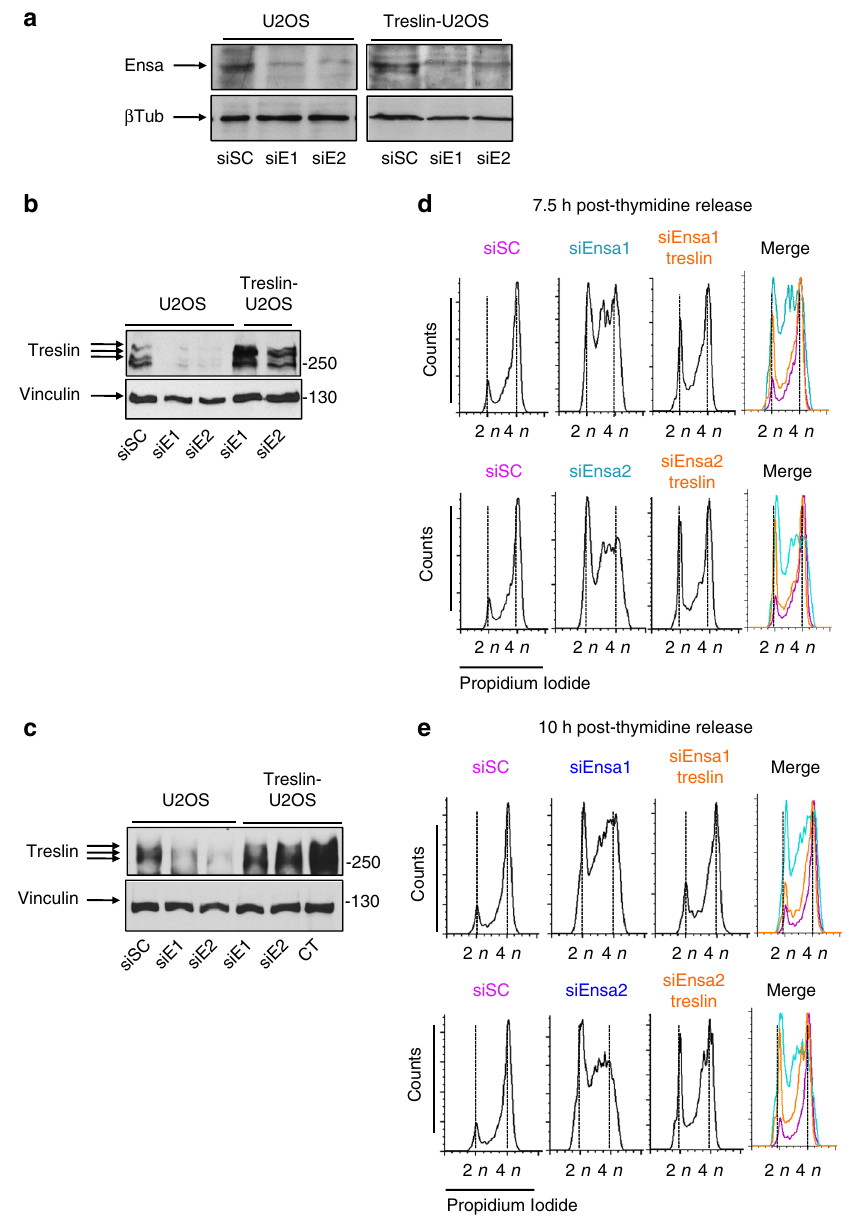
Fig. 8 Overexpression of Treslin in Ensa siRNA-treated cells rescues normal S phase. a Parental or U2OS cells stably overexpressing AcGFP-Flag-Treslin were transfected with scramble (siSC) or Ensa siRNAs #1 (siE1) or #2 (siE2) (for parental) or with Ensa siRNA #1 and #2 (for AcGFP-Flag-Treslin overexpressing cells) and the levels of Ensa and β -tubulin as a loading control, checked by western blot. Cells were synchronised in G1 – S by thymidine block 24 h later and recovered for western blot at 7.5 h b and 10 h c after release. The levels of Treslin in non-transfected U2OS cells stably overexpressing AcGFP-Flag-Treslin were also checked (CT). FACS analysis at 7.5 h d and 10 h e after release are also